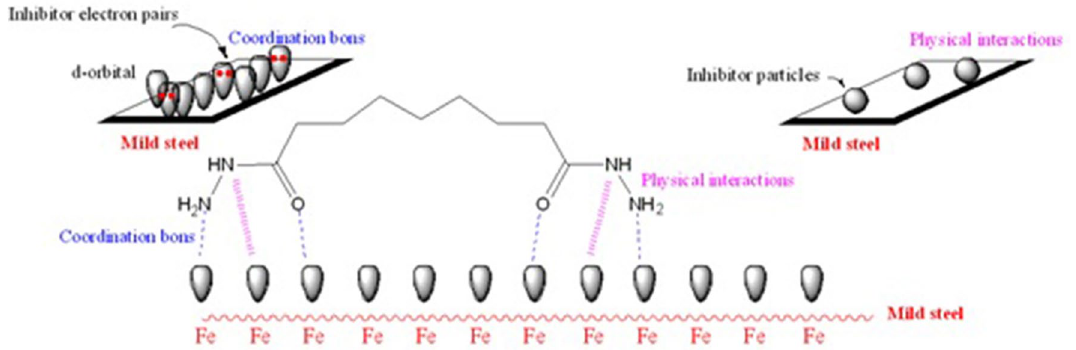
Figure 18. Proposed protection mechanism for MS by the inhibitor via chemical and physical adsorption processes.